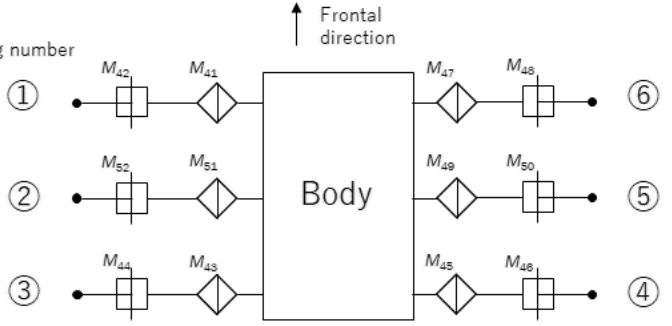
Figure 6. Joint placement and structure of Robot 2 in a top view. Motor IDs M 41 to M 52 are assigned to Robot 2.